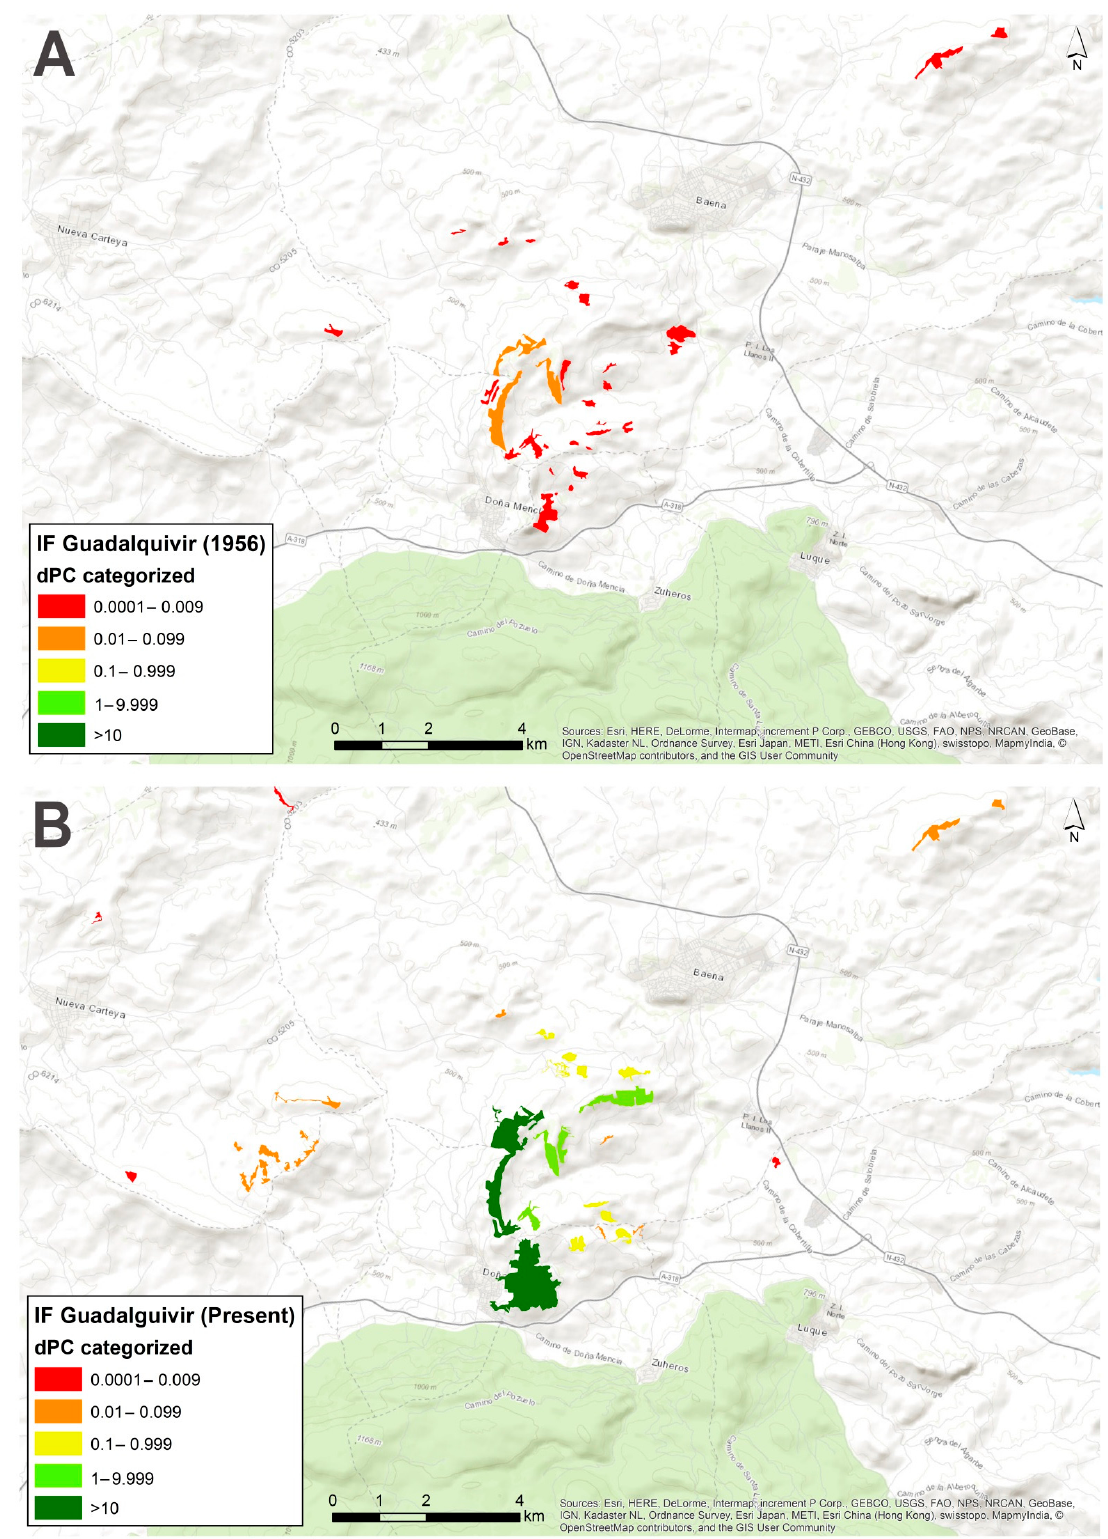
Figure 8. A comparative analysis of the fragmentation status in an area located to the southwest of the village of Baena (Córdoba, Spain). In this case, the situation in the present day ( B ) has improved with respect to 1956 ( A ).